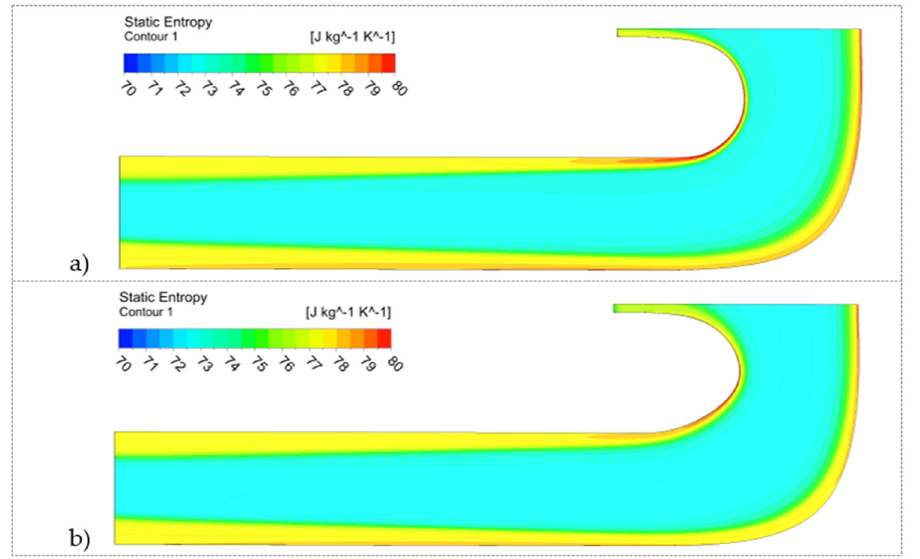
Figure 12 . Static entropy contour for ( a ) intermediate and ( b ) optimized geometry. Figure 12. Static entropy contour for ( a ) intermediate and ( b ) optimized